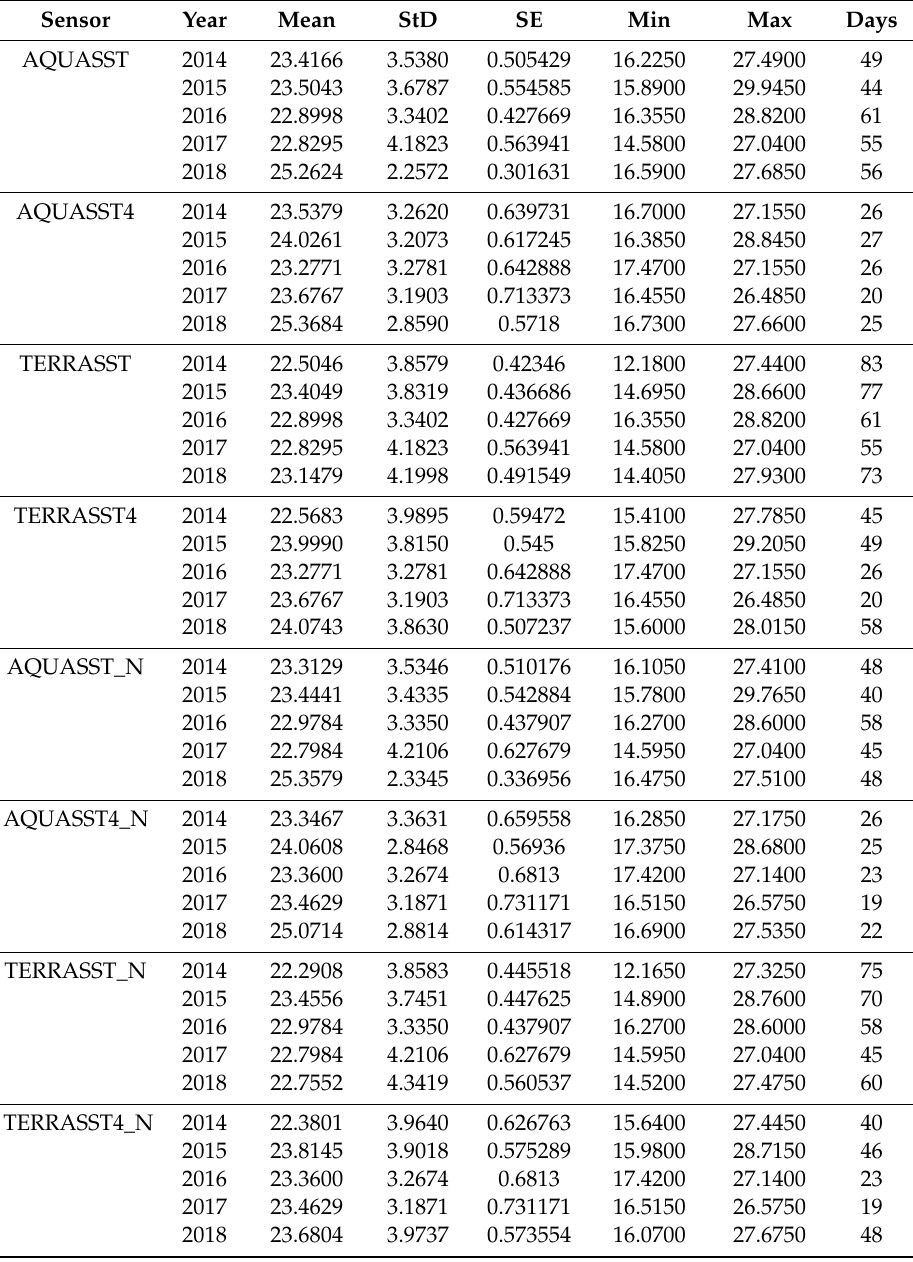
Table A3. Statistical data extracted from remote-sensing satellite measurements with quality flag values of 0, 1, and 2. The mean value, the standard deviation, the standard error, the minimum, and maximum values for each data series are presented. Additionally, the number of days that had the corresponding quality flag values for every year is presented. Data series with the ‘_N’ ending refer to the northern cell of the satellite swath from the cell that contains the Seafloor Observatory of the Biotechnological Park of